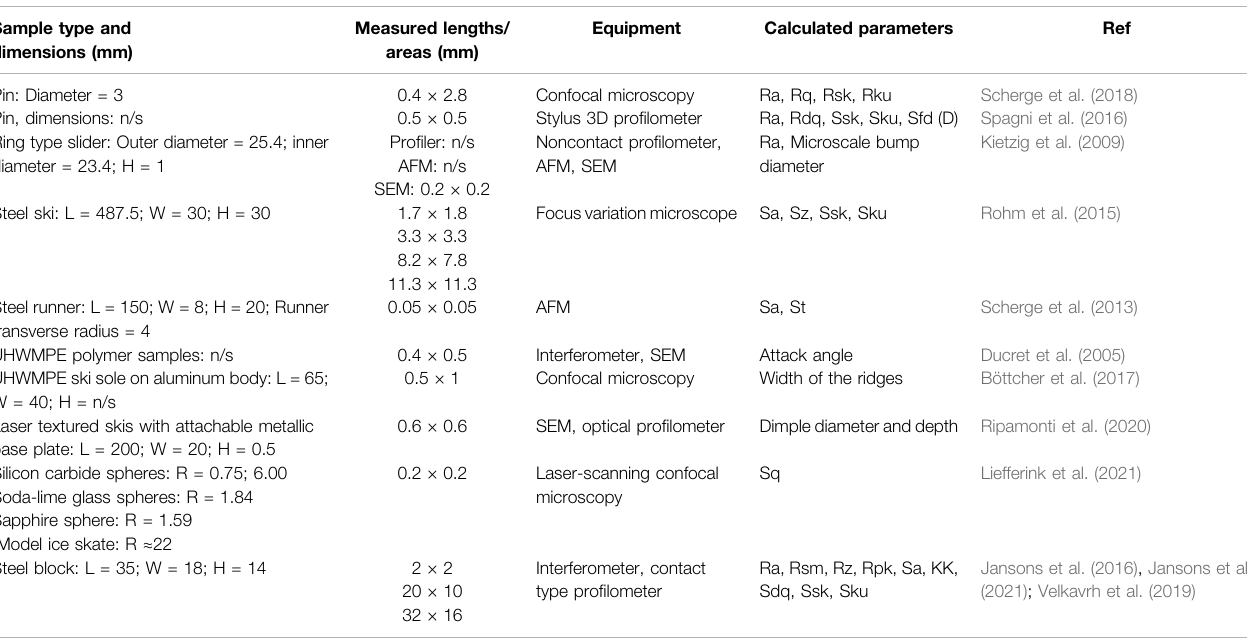
TABLE 3 | Examples of ice friction research texture